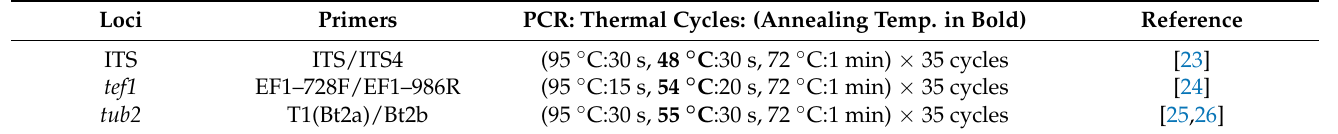
Table 1. Loci used in this study with PCR primers, and the process. Loci Primers PCR: Thermal Cycles: (Annealing Temp. in Bold) Reference